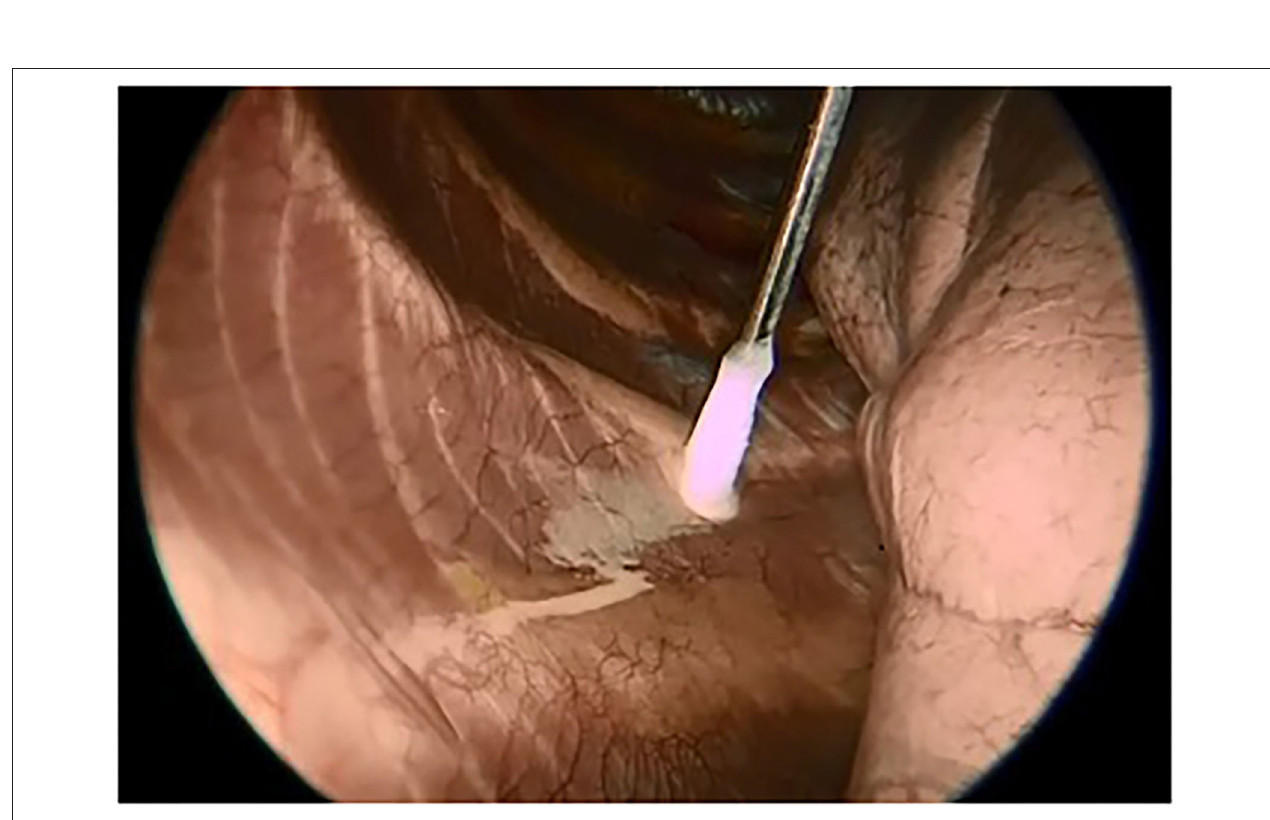
FIGURE 1 | The cryoanalgesia probe with the double cannula, which allows the creation of the ice ball just at the tip of the probe.